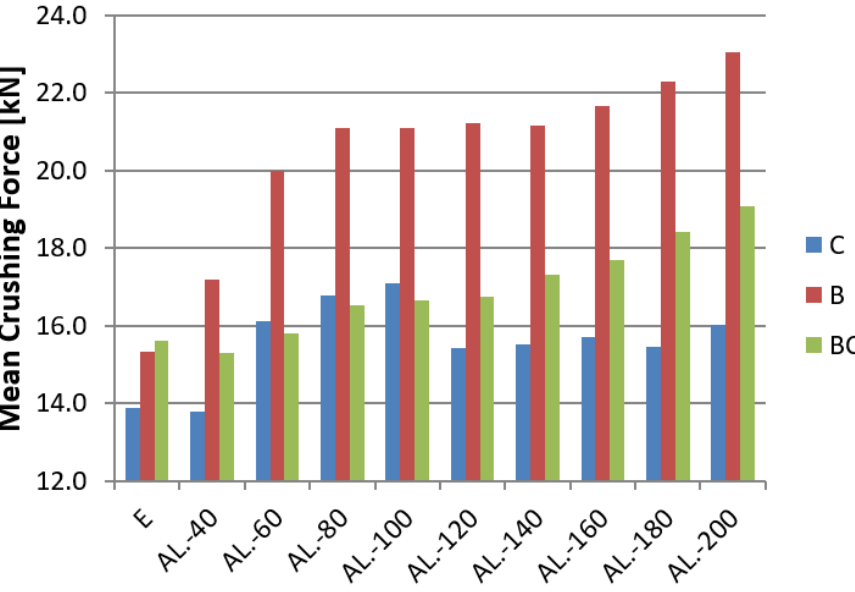
Figure 17. Mean Crushing Force for whole length range of aluminum foam filling. The average force increases with foam length for all trigger shapes. The jumping trend can be witnessed, especially for the 60–100 mm range where the increase in value is highest.